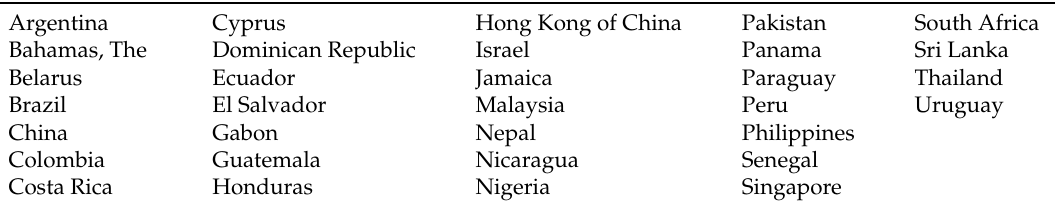
Table A2. List of non-OCDE